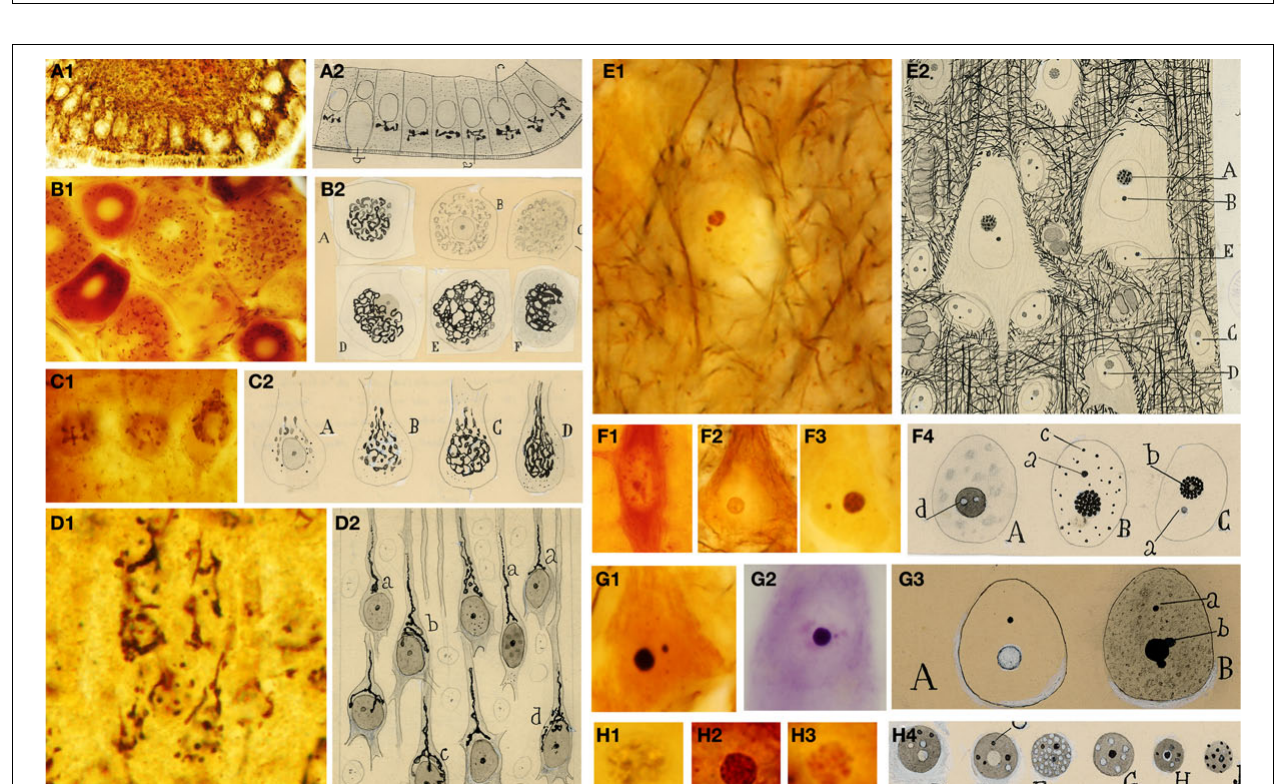
FIGURE 6 | Cajal’s histological preparations and drawings showing some contributions to cellular biology. (A) Golgi apparatus of lumbricus (formalin-uranium nitrate); (B) Golgi apparatus in ganglionic cells (formalin-uranium nitrate); (C) Golgi apparatus in Purkinje cells (formalin-uranium nitrate); (D) Golgi apparatus in pyramidal cells